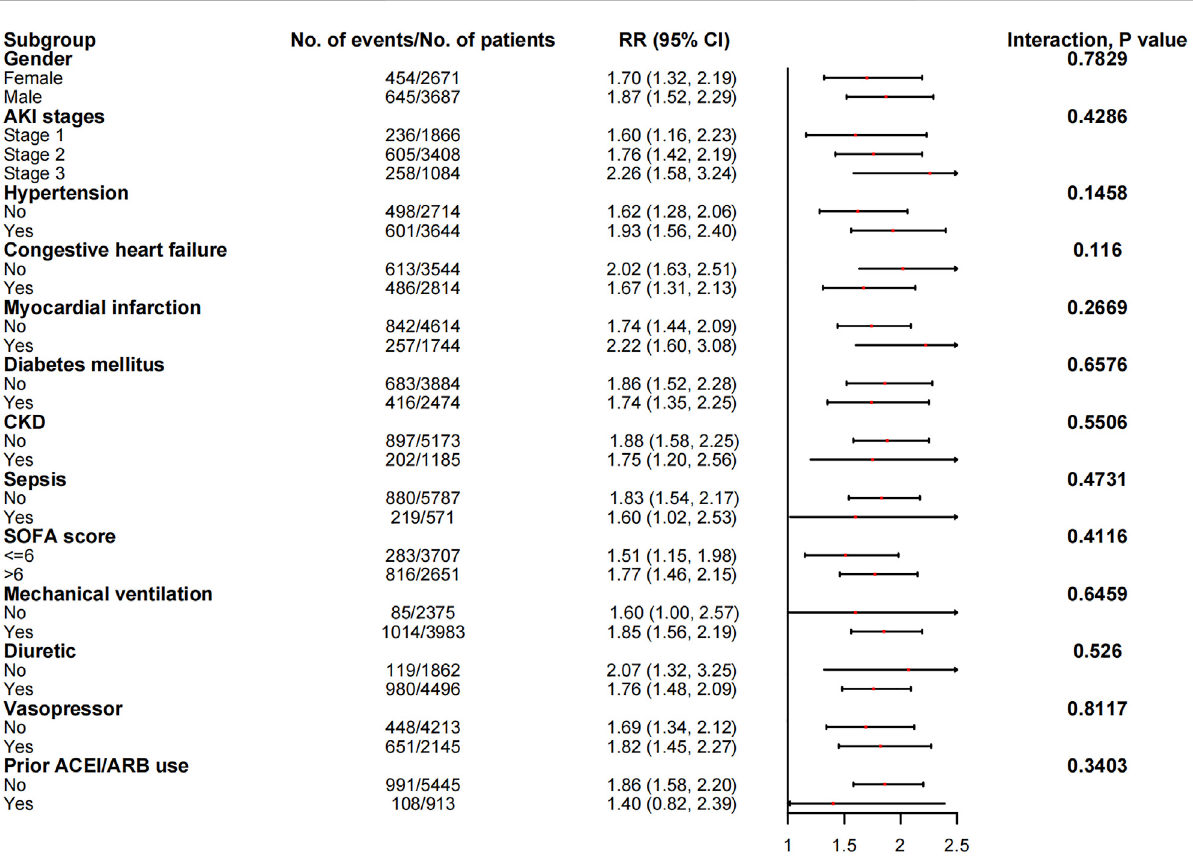
FIGURE 6 The association between ACEI/ARB use and AKD in the subgroups. Abbreviations: AKI, acute kidney injury; ACEI, angiotensin-converting enzyme inhibitor; ARB, angiotensin receptor blocker; AKD, acute kidney disease; CI, con fi dence interval; CKD, chronic kidney disease; RR, risk ratio; SOFA, sequential organ failure assessment